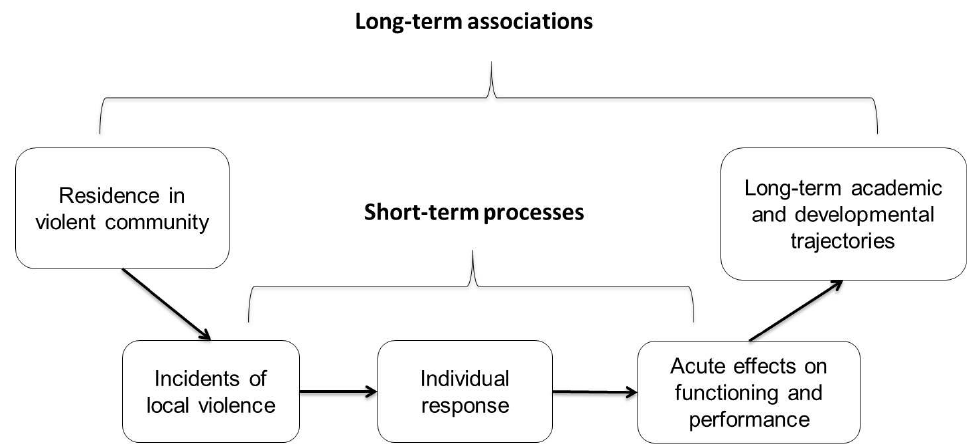
Figure 1: A conceptual model of the short-term processes linking residence in a violent neighborhood Figure 1. Blockface geography. Students living in the shaded parts of adjacent census blocks would be coded as residing on the same blockface, and would be coded as exposed to the same incidents of with students’ long-term academic and developmental crime.